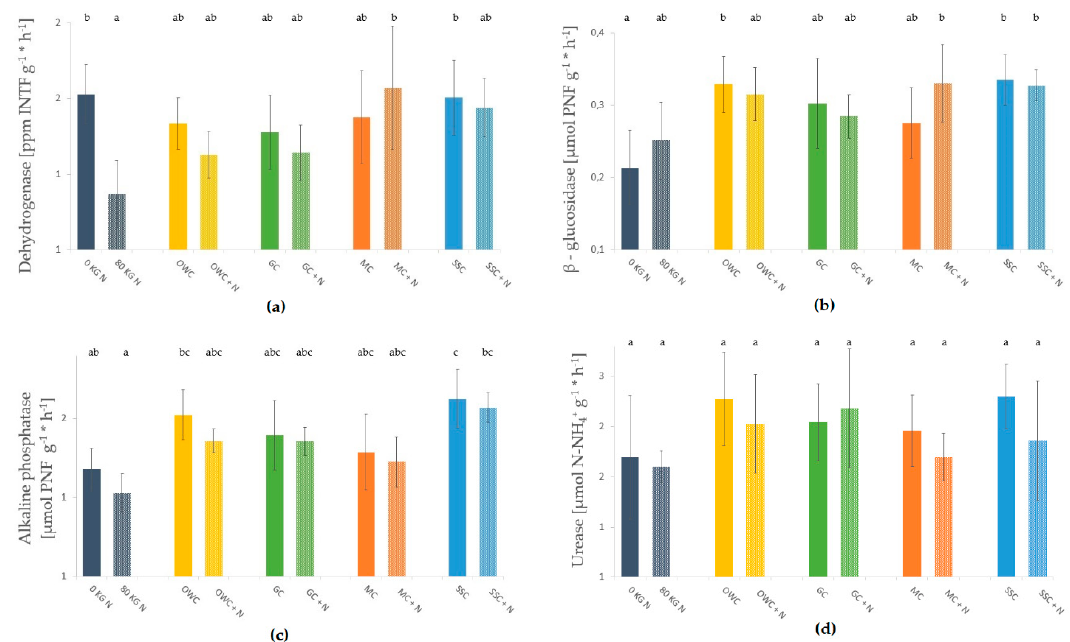
Figure 3. Soil enzymatic activities (dehydrogenase ( a ), β -glucosidase ( b ), alkaline phosphatase ( c ) and urease ( d )) (mean ± SD; n = 4). Columns with the same lowercases letters are not significantly different ( p ≤ 0.05) between treatments. Control (0 kg N), 80 kg mineral N ha − 1 (80 kg N), 175 kg N ha − 1 of composts, urban organic waste compost (OWC), green waste compost (GC), farm yard manure compost (MC), sewage sludge compost (SSC), + N application of 80 kg N ha − 1 .